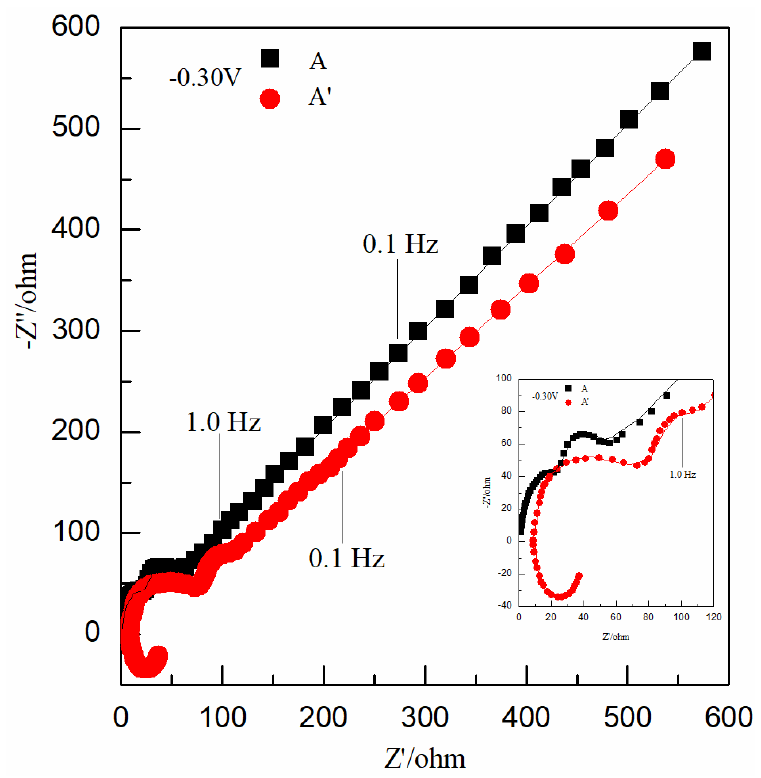
Figure 2. Nyquist plots obtained at − 0.30 V in Cu(II) unitary solutions: curve A in solution 1 without PEG; curve A (cid:48) in solution 2 with 4 µ M PEG. Inset: Partly amplified Nyquist plots of Figure